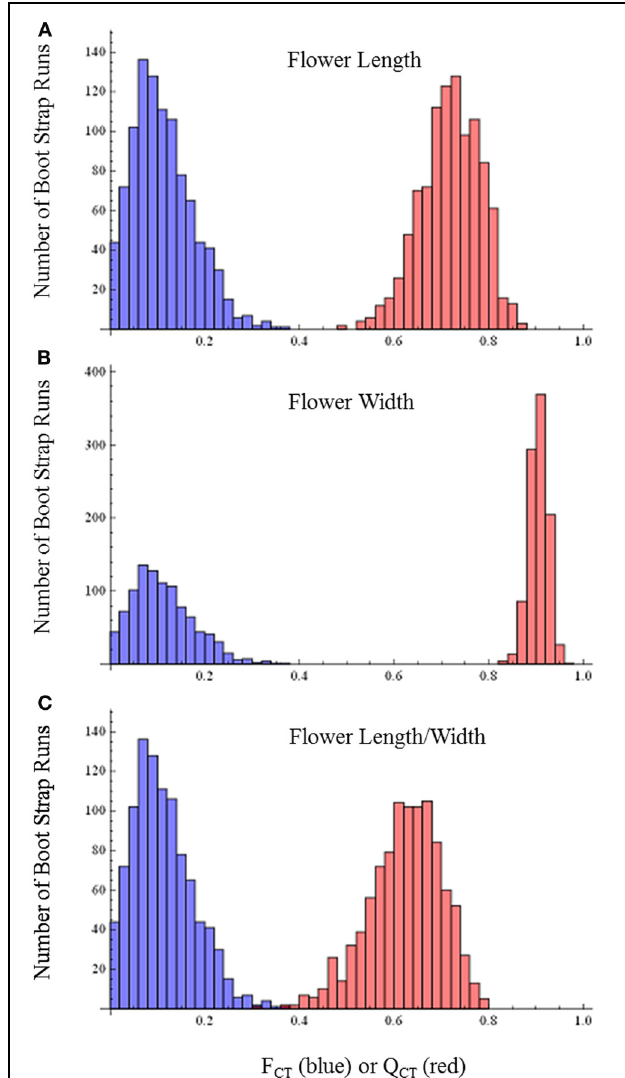
FIGURE 3 | F CT vs. Q CT analyses (A) flower length ( p < 0 . 001) (B) flower width ( p < 0 . 001) (C) flower length-width ratio ( p < 0 .